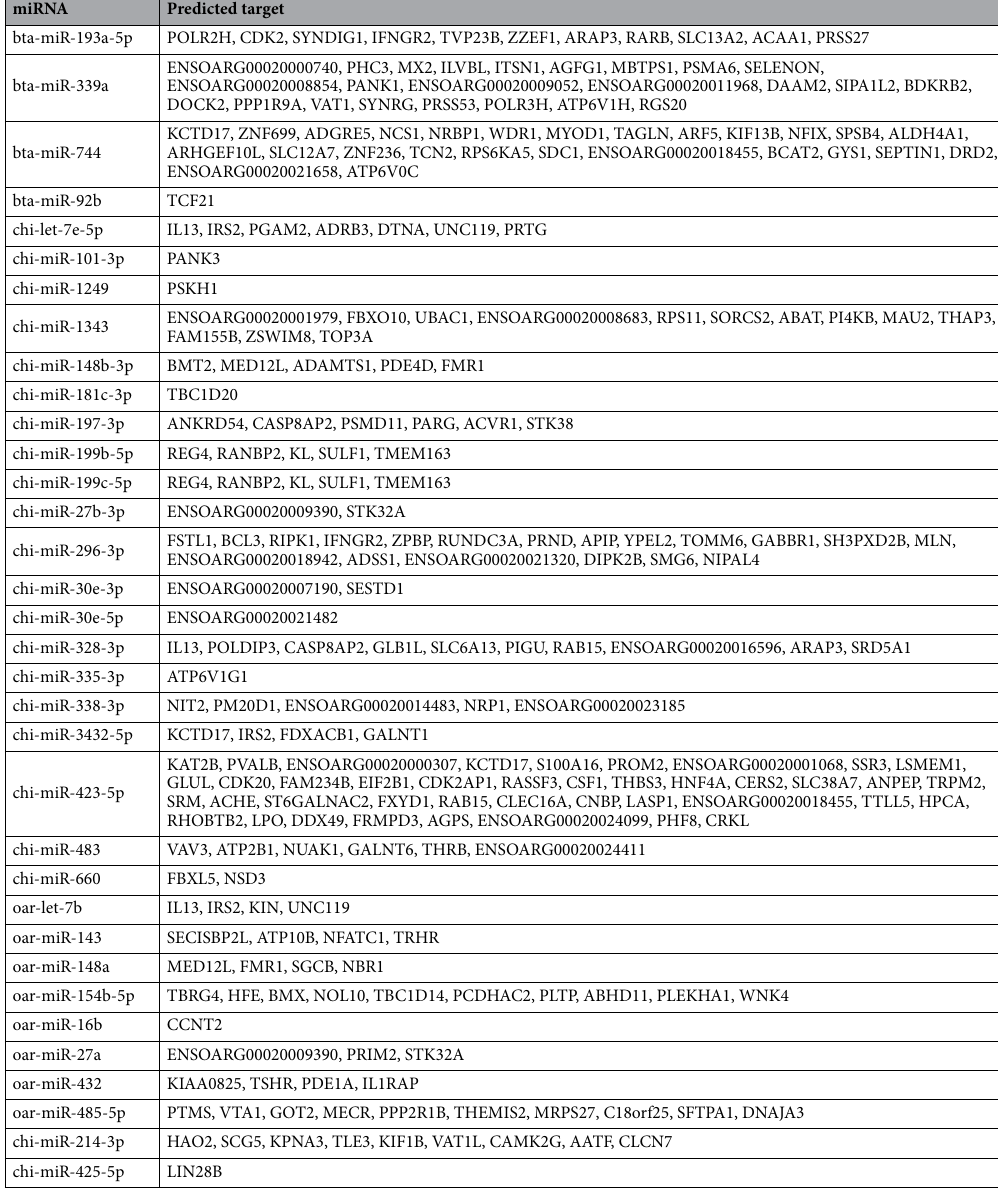
Table 3. Predicted targets of the differentially expressed miRNAs. The intersection of four different tools (miranda, pita, targetscan and tarpmir) were used for miRNA target